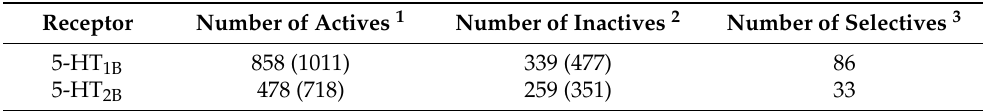
Table 1. Active, inactive, and selective 5-HT 1B and 5-HT 2B ligands retrieved from the ChEMBL with at least 22 heavy